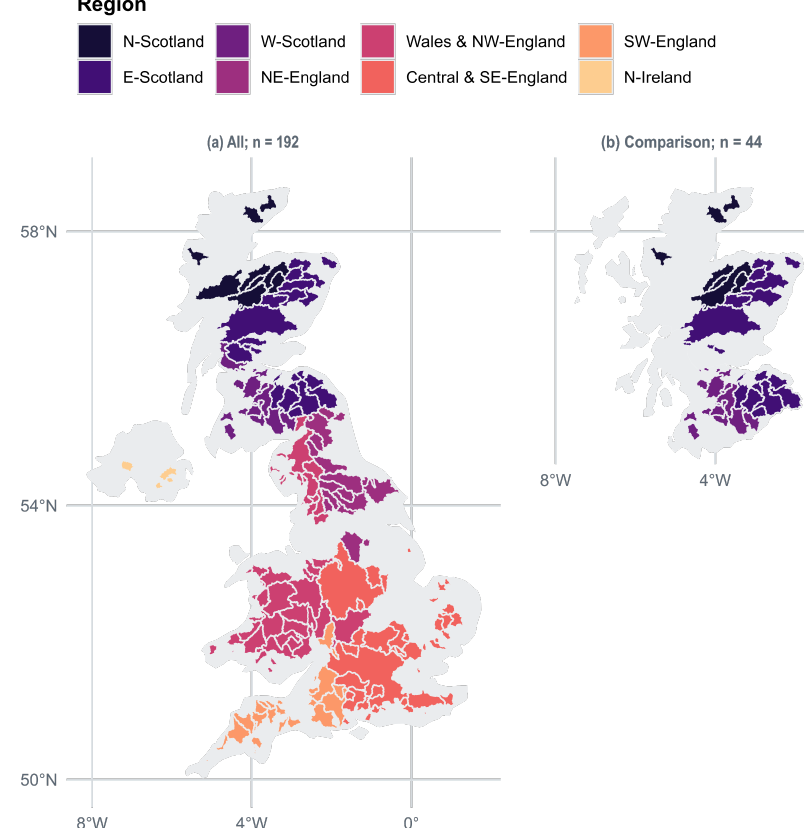
Figure 3. Map of ( a ) the 192 UK catchments analysed in this study; and ( b ) the 44 Scottish catchments analysed for the comparison with Collet et al. [20]. Catchment fill colour is by region; these regions are the focus of the regional